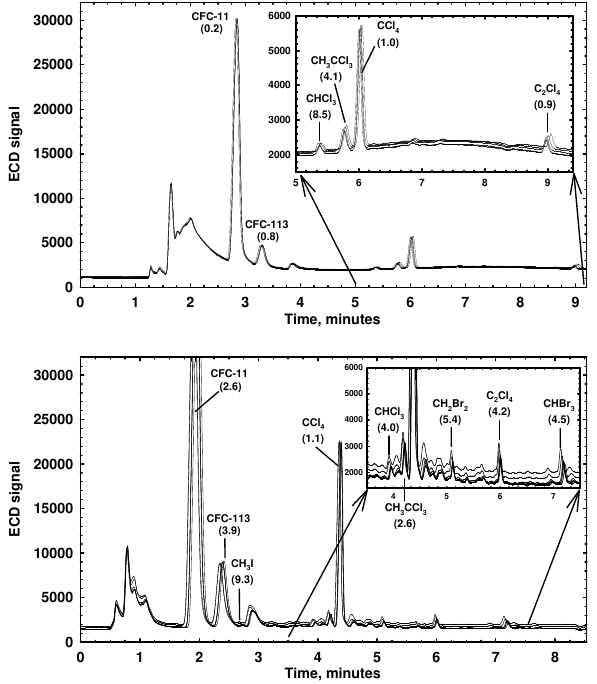
Fig. 7. Overlaid chromatograms of calibration air during opera- tion in the laboratory (upper panel) and in Cape Verde in June 2007 (lower panel). The precision of the peak heights (RSD,%) are shown in parentheses, each chromatogram is generated from a 20cm 3 volume of Niwot Ridge air (NOAA-ESRL) spiked with CH 3 I, CH 2 Br 2 and CHBr 3 .